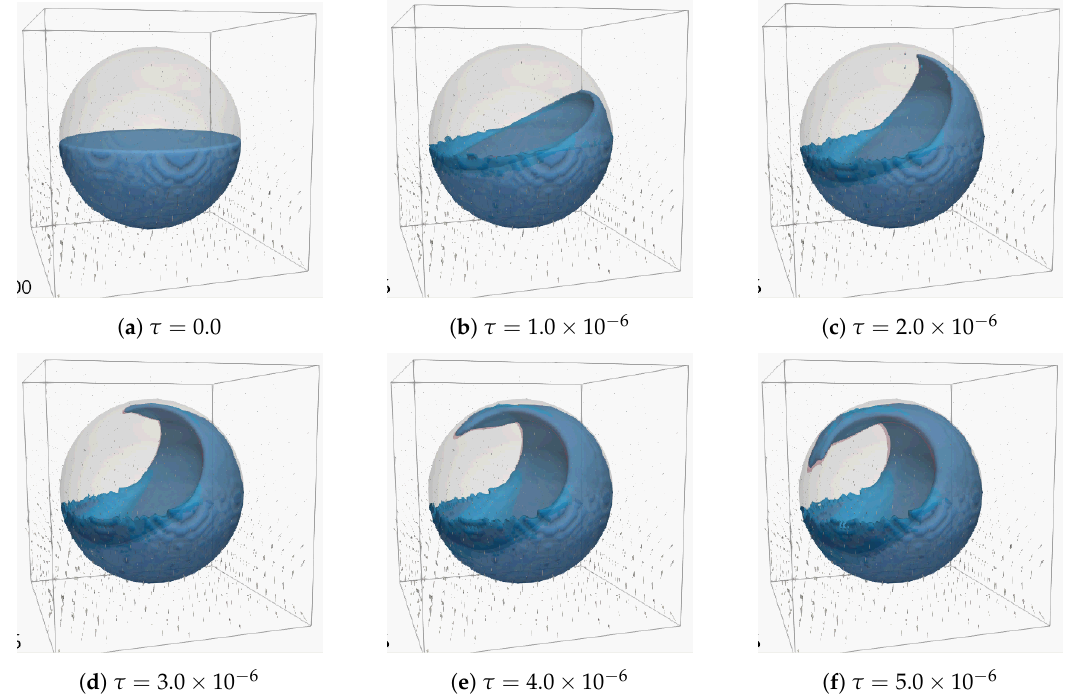
Figure 11. Computational results of Case 2 ( D / L = 2.0, H = 0.0, b c = 0.1 [T]; i.e., coil is larger, closer to the tank and magnetic flux density is weak). The blue color indicates the movement of liquid phase damped by the magnetic force, whereas the pink color indicates that in Case 0 (no magnetic force). The black vectors represent the magnetic field generated by the coil